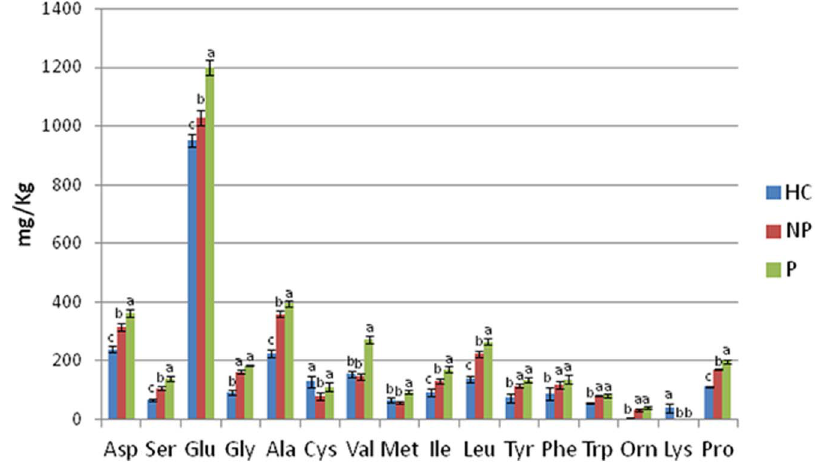
Figure 6. Fecal levels of free amino acids (FAA) in subjects. Concentration (mg/kg) of individual free amino acids (FAA) found in the fecal samples of immunoglobulin A nephropathy (IgAN) non progressor (NP) and progressor (P) patients, and healthy controls (HC). Data are the means of three independent experiments and standard deviations, performed in duplicate ( n =6).